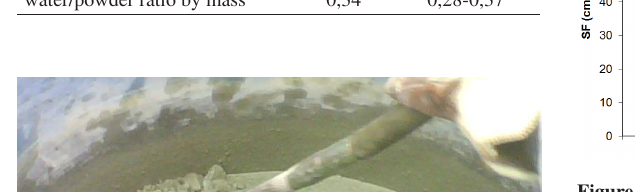
Figure 5. Results of the slump flow test of the SCCs.